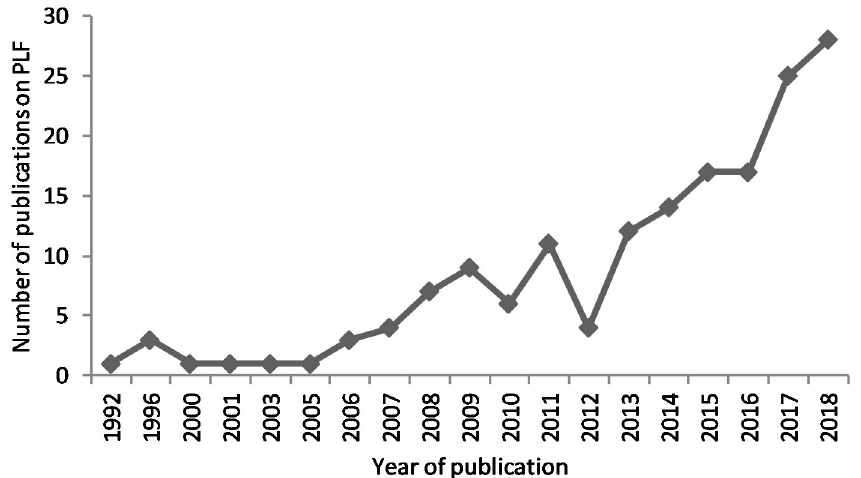
Fig 1. Historical chart, obtained via scopus, for the number of publications mentioning ‘Precision Livestock Farming’ in the title or abstract.